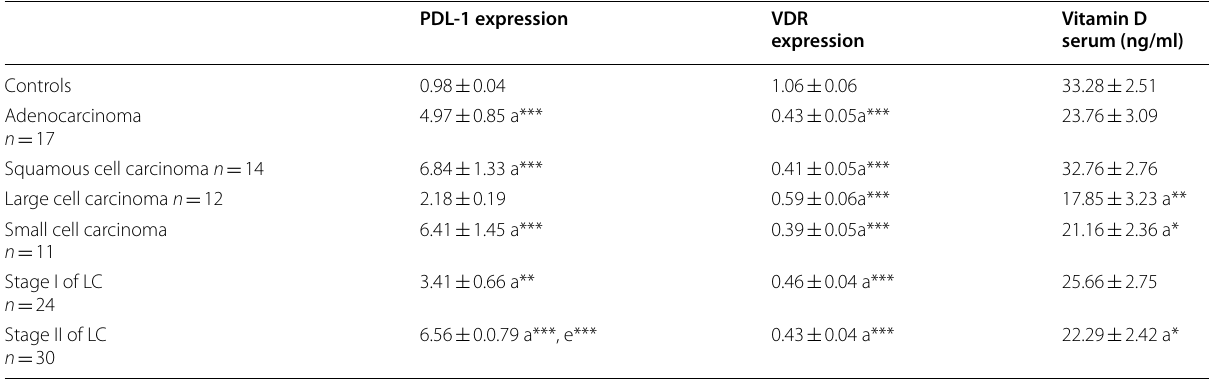
Table 2 Tissue expression of PDL‑1, VDR with serum vit. D level for studied markers in control and different pathological types of lung